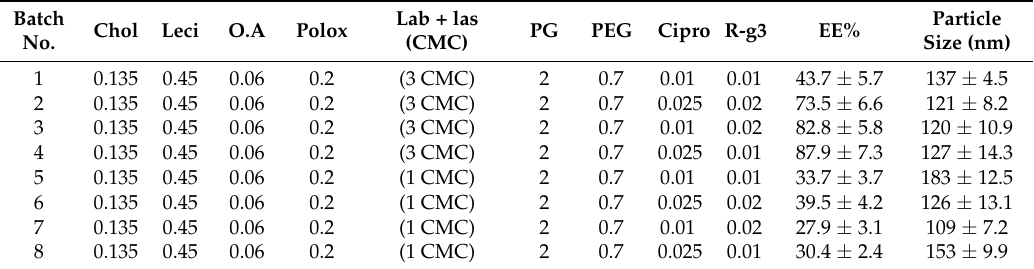
Table 1. Formulations components (concentrations are presented as gram unit) and their particle size and entrapment efficiency (EE%) (Mean ± SD, n = 5). Batch